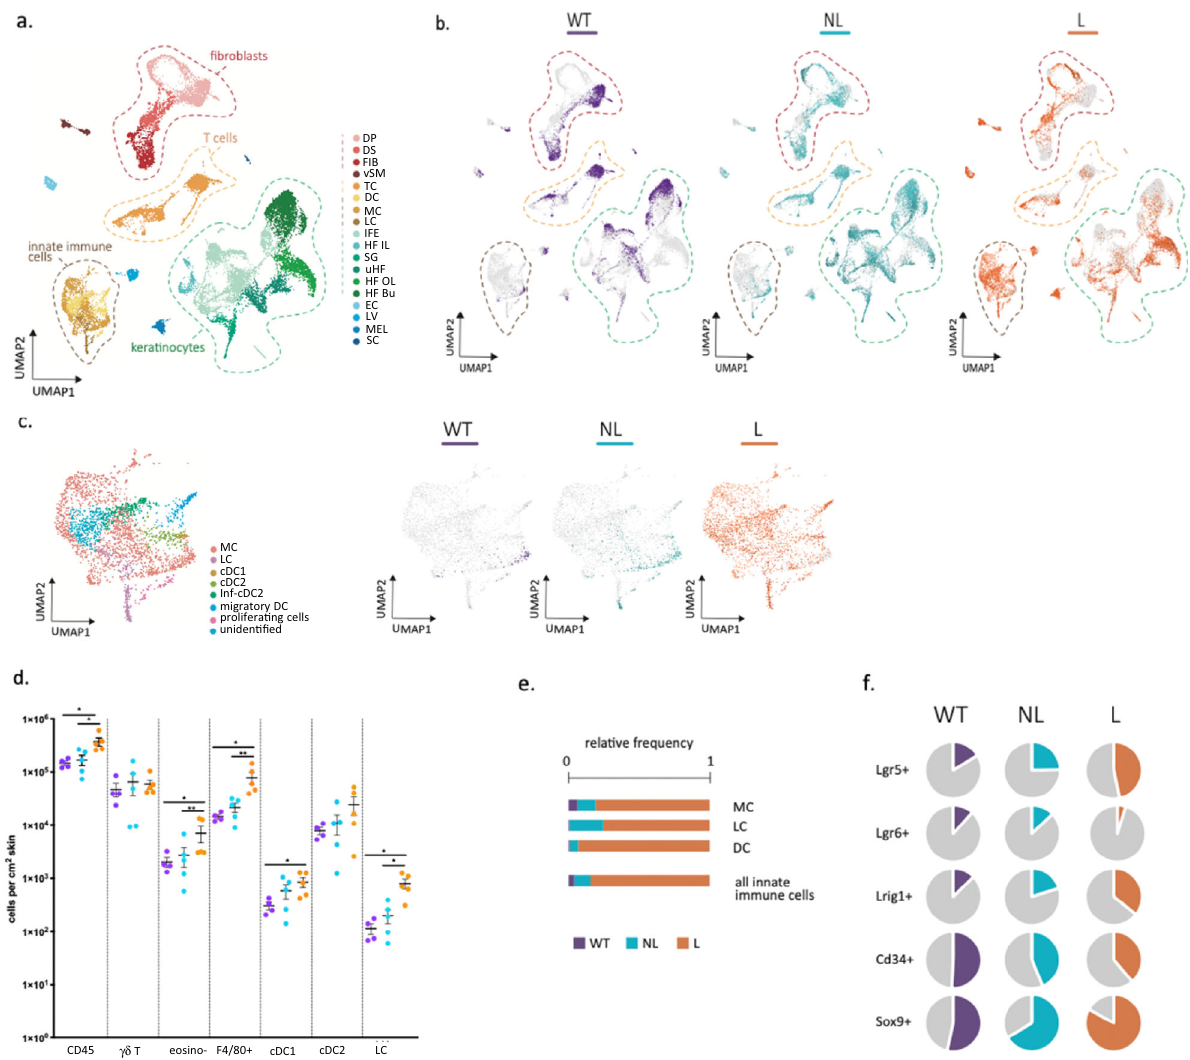
Fig. 4 Single-cell RNA-sequencing reveals marked in fi ltration of innate immune cells and changes in hair follicle stem cell lineage in Δ Ker OTULIN mice. a Annotated UMAP clustering of live skin cells isolated from control OTULIN fl / fl mice (WT) and from non-lesional (NL) and lesional (L) total skin of Δ Ker OTULIN mice (DP dermal papilla, DS dermal sheath, FIB fi broblasts, vSM vascular smooth muscle, TC T-cells, DC dendritic cells, MC macrophages, LH Langerhans cells, IFE interfollicular epidermis (including infundibulum), HF IL hair follicle anagen inner layer cells, SG sebaceous gland, uHF upper hair follicle, HF OL hair follicle anagen outer layer cells, HF Bu hair follicle bulge, EC endothelial cells, LV lymph vessel, MEL melanocytes, SC Schwann cells). b Distribution of WT, NL, and L cells within the cell clusters. c UMAP plot of annotated innate immune cell subcluster, showing assigned clusters and distribution of WT, NL, and L cells within this cluster. d Flow cytometric analysis of immune cell composition in control OTULIN fl / fl skin (WT, n = 4 mice) and non-lesional (NL) and lesional (L) skin of Δ Ker OTULIN mice ( n = 5 mice per condition). The absolute number of immune cells per cm 2 skin is plotted, data represent means ± SEM. (Mann − Whitney two-sided test; * p < 0.5; ** p < 0.01; *** p < 0.001; **** p < 0.0001). e Relative normalized cell frequencies of the indicated immune cell-types in the different conditions (LH Langerhans cells, MC macrophages, DC dendritic cells). f percentage of keratinocytes expressing the indicated HFSC markers within the total keratinocyte population of WT, NL and L